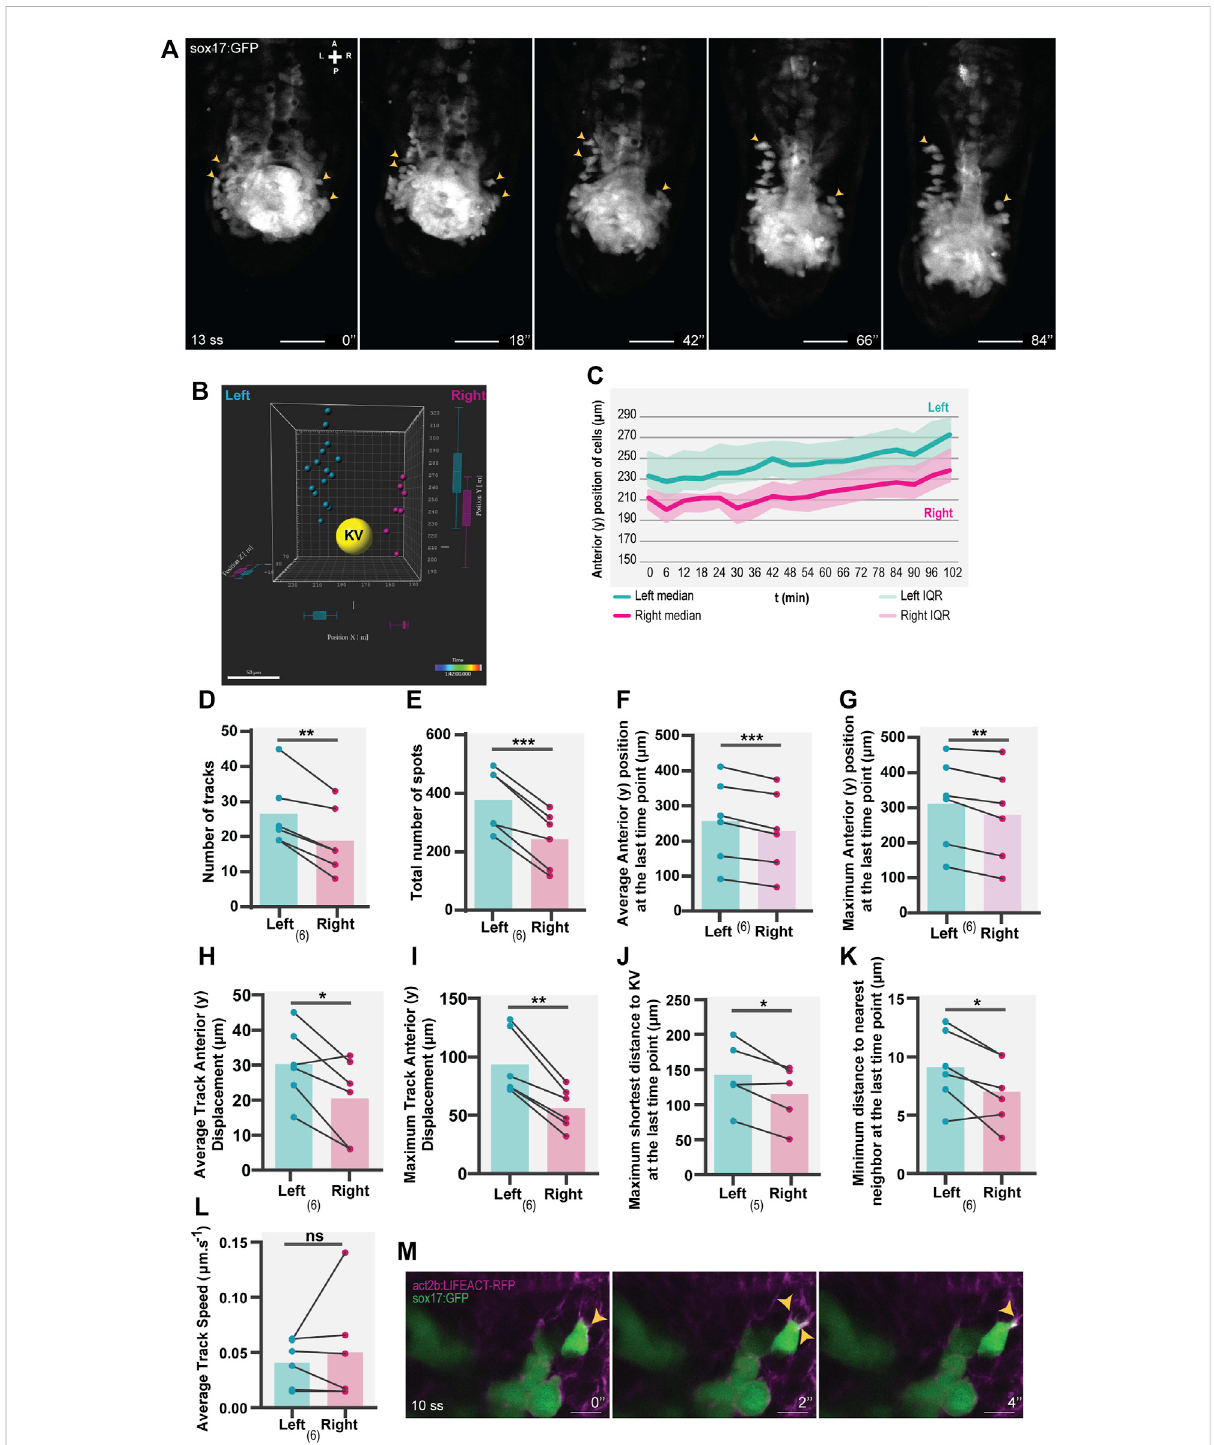
FIGURE 1 Asymmetric patterns of NKSTCs in WT embryos. (A) Time-lapse images of selected time points of a Tg(sox17:GFP) embryo starting at 13 ss and ending at 18 ss. Yellow arrowheads indicate the more anterior positions on the left and right sides. The elapsed time is indicated in minutes ( ‘ ) at the bottom-right. Scale bar = 50 µm. (B) 3D distribution of manually tracked cells at the last time-point imaged. Left spots are shown in cyan, right in magenta, and the KV lumen in yellow. (C) Dynamics of the anterior positions at consecutive time points on the left (cyan) and right (magenta) sides. The thick lines represent the medians. (D – L) Left vs right parameters extracted from cell tracking data, cyan represents the left side, and magenta represents the right side. t -test paired comparisons and IQR means interquartile range. Bars represent mean values and dots represent individual embryos. *corresponds to a p -value < 0.05; ** to a p -value < 0.005 and *** to a p -value < 0.0005. (M) Lamellipodium-like (yellow arrowheads) structures in NKSTCs observed in Tg(act2b:LIFEACT-RFP);Tg(sox17:GFP). Scale bar = 10 µm. Axes indicate A, anterior; P, posterior; L, left; R, right. N is shown in